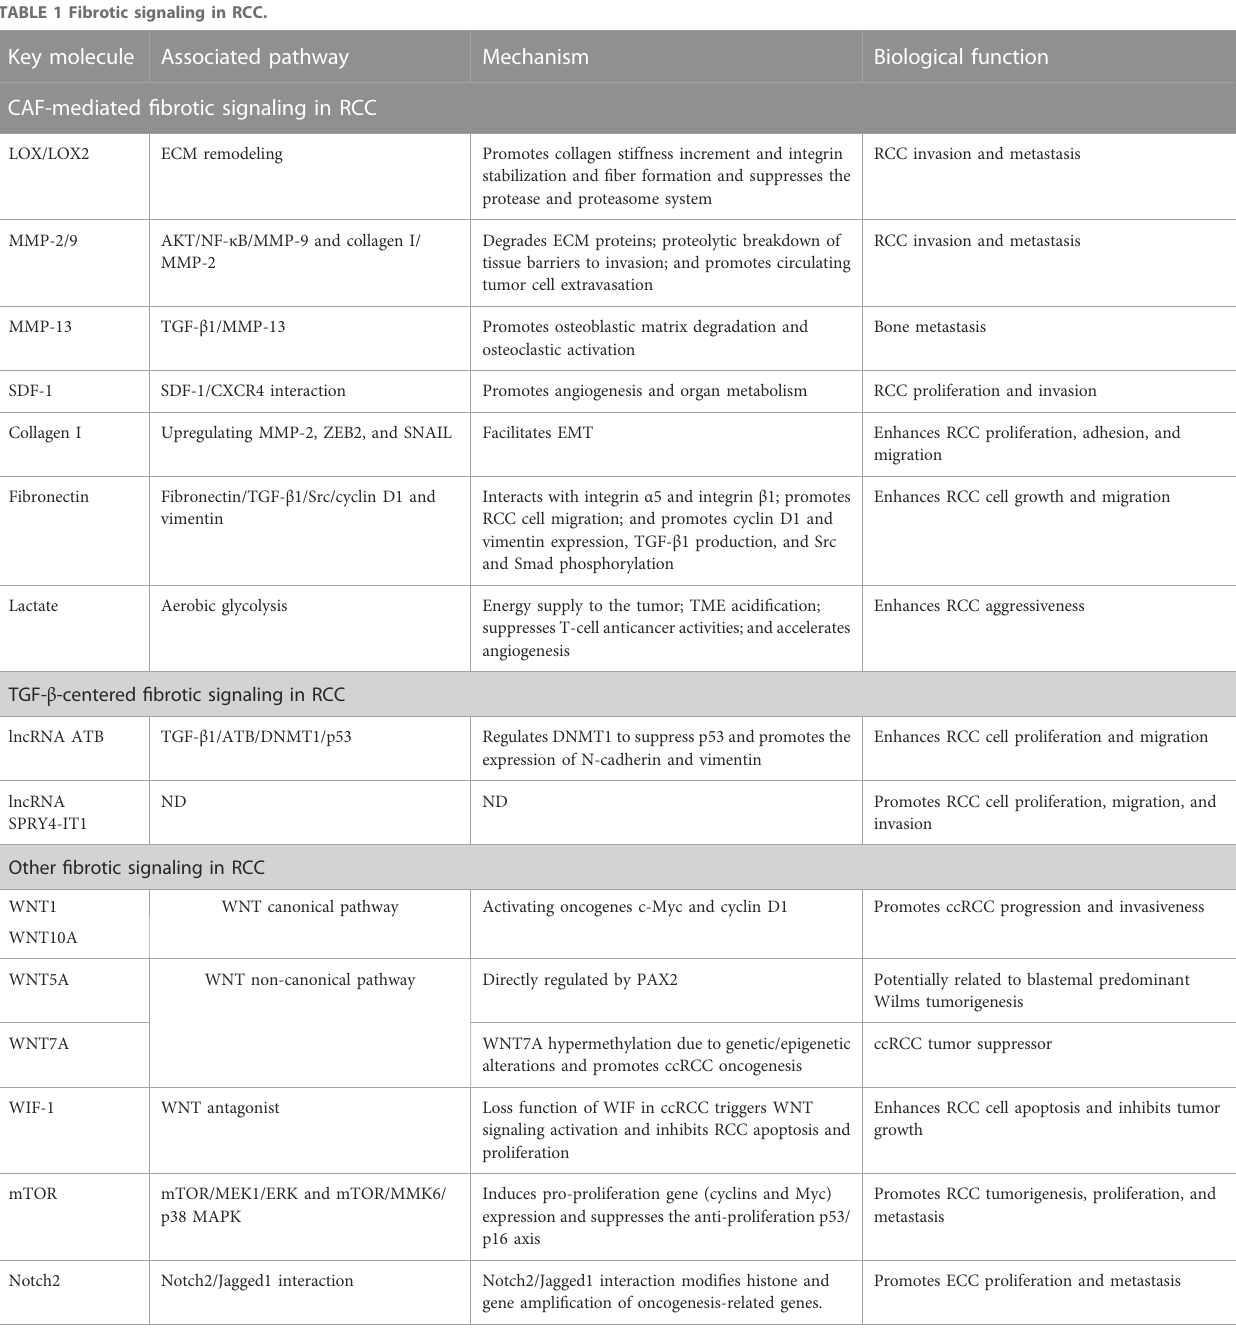
TABLE 1 Fibrotic signaling in RCC. Key molecule Associated